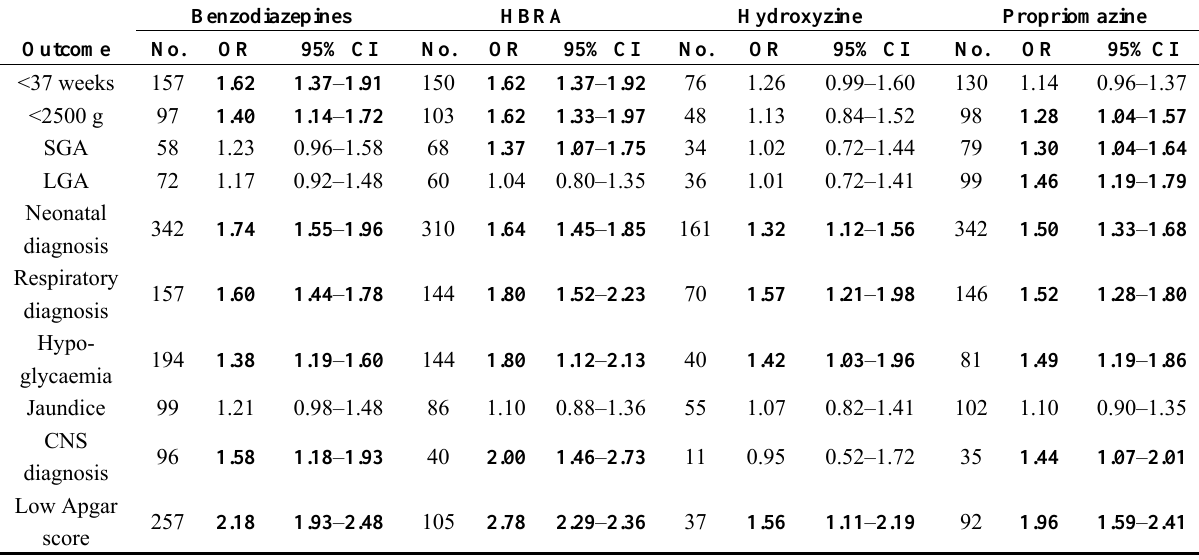
Table 27. Neonatal outcome for four different groups of sedatives/hypnotics: benzodiazepine, HBRA, hydroxyzine, and propiomazine. Bold text marks statistical significance. Benzodiazepines HBRA Hydroxyzine